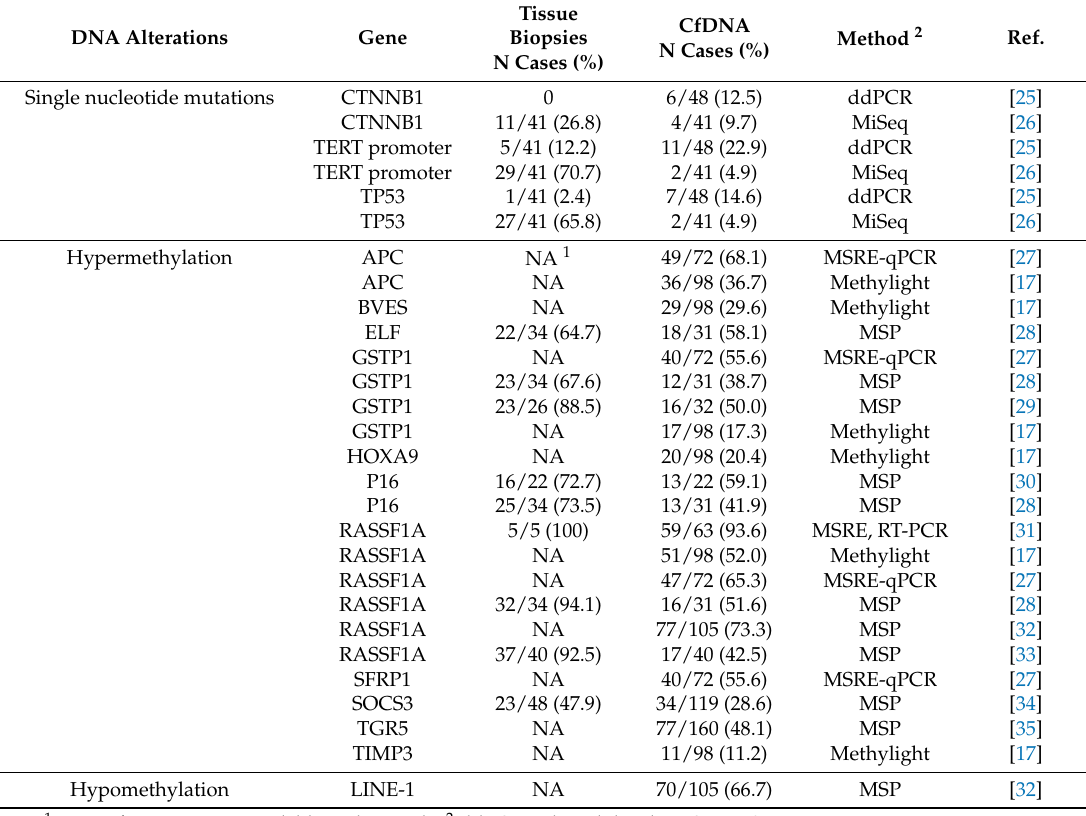
Table 1. Summary of published articles retrieved from Pubmed on the role of somatic mutations and methylation in non-invasive diagnosis in liver